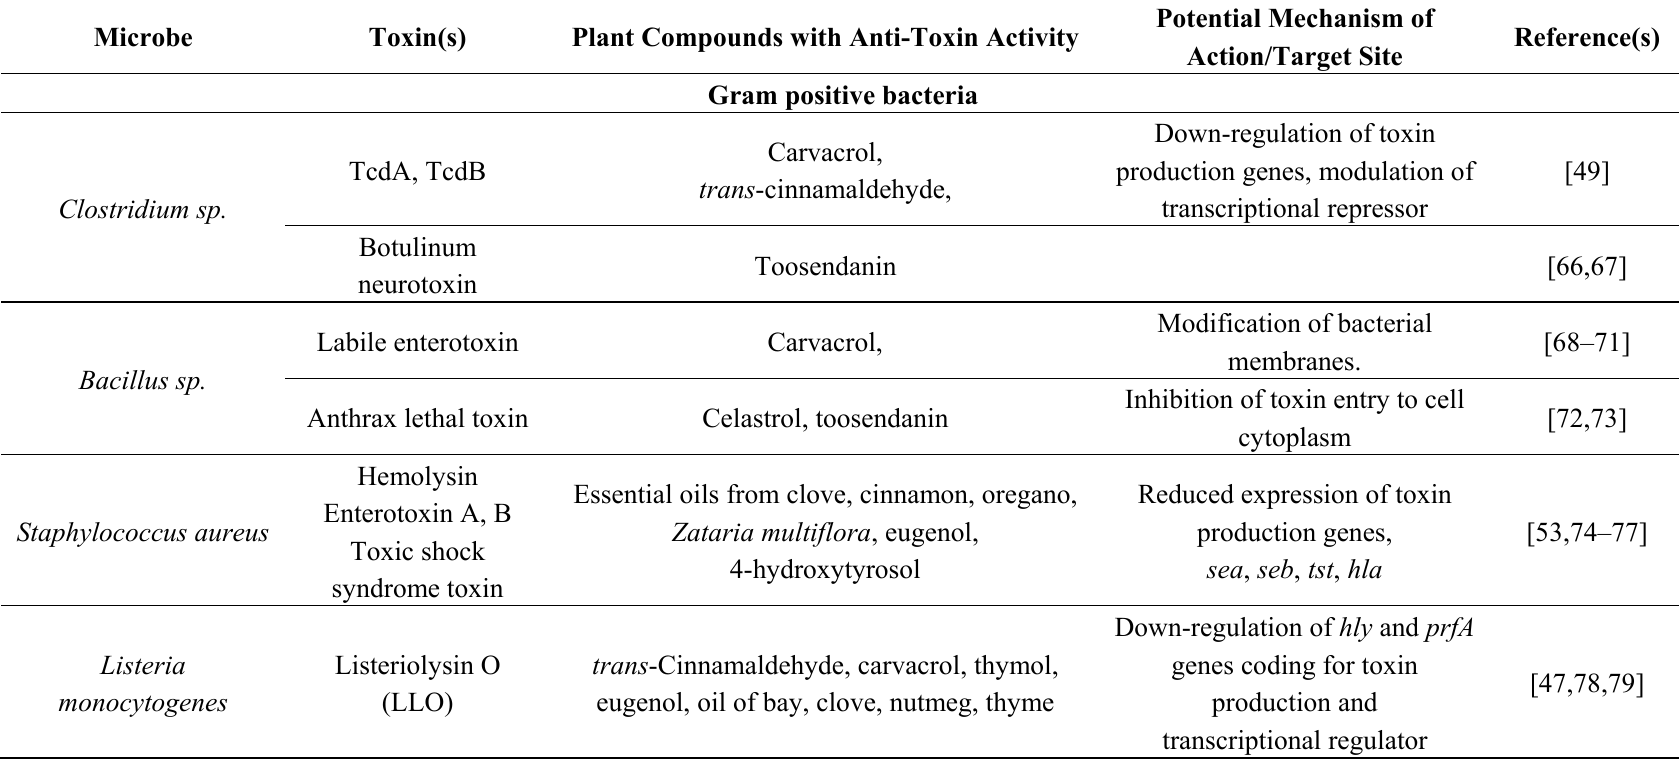
Table 1. Studies illustrating the efficacy of plant-derived compounds and plant extracts in reducing toxin production in microbes with potential mechanism(s) of